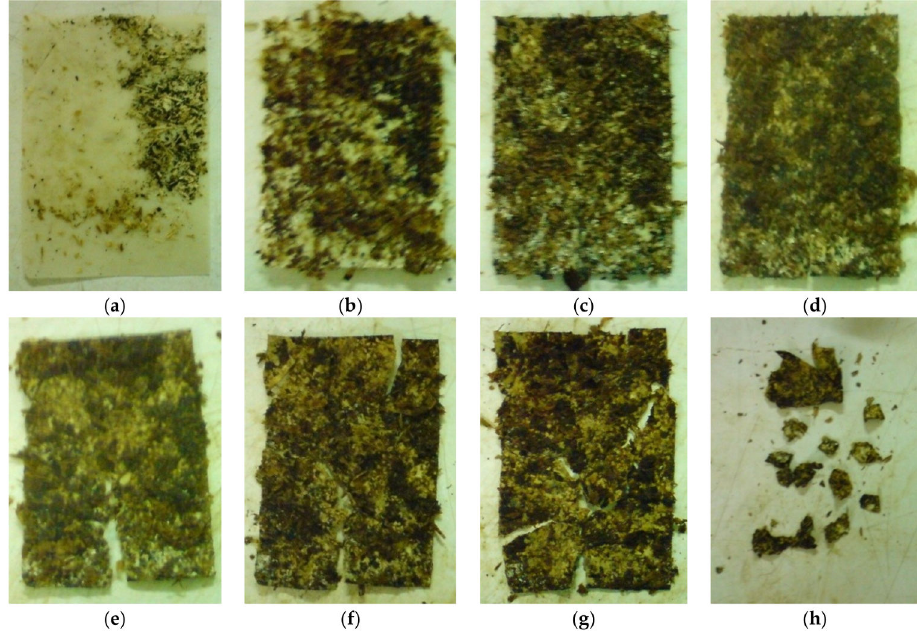
Figure 11. Determination of the degree of disintegration—photos of sample during the test: ( a ) 4th day; ( b ) 12th day; ( c ) 25th day; ( d ) 29th day; ( e ) 32nd day; ( f ) 35th day; ( g ) 42nd day; and, ( h ) 55th day. Table 5. Subjective rating of the degree of disintegration during test—preserved sample amount (in %). Day 1